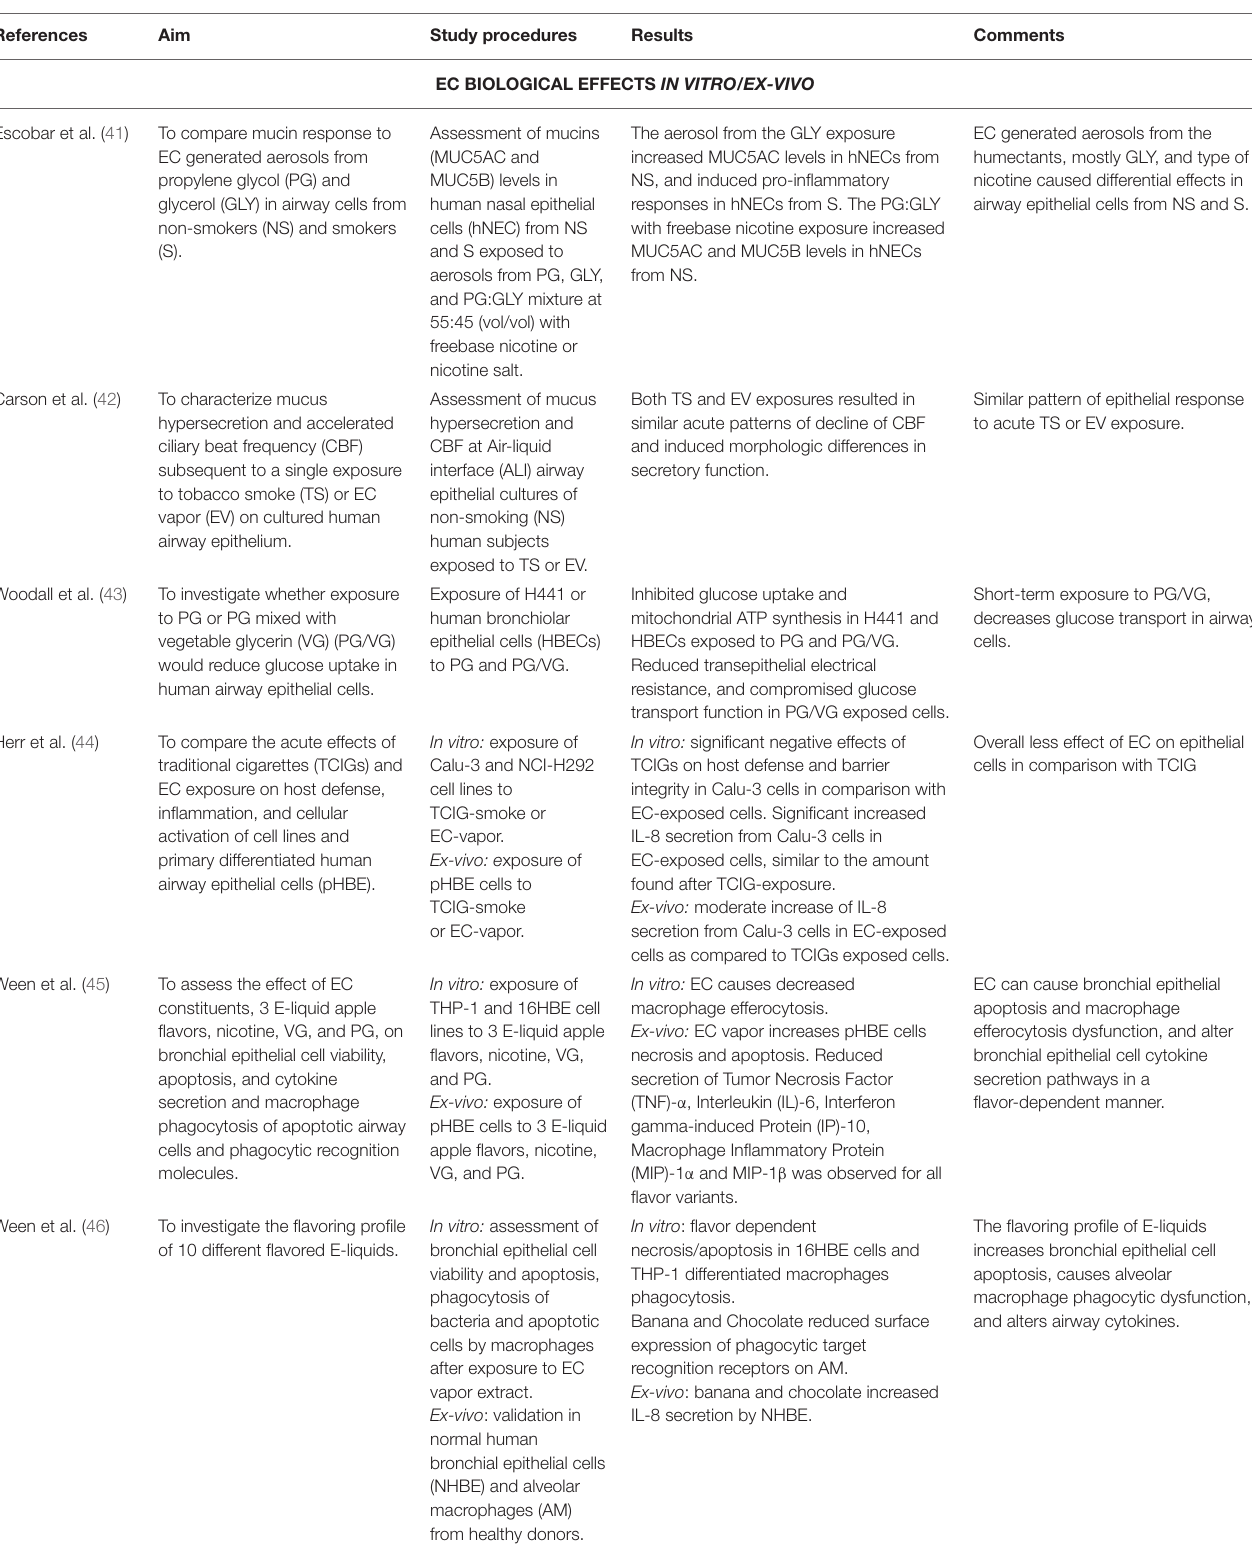
TABLE 2 | Biological evidence of EC on the